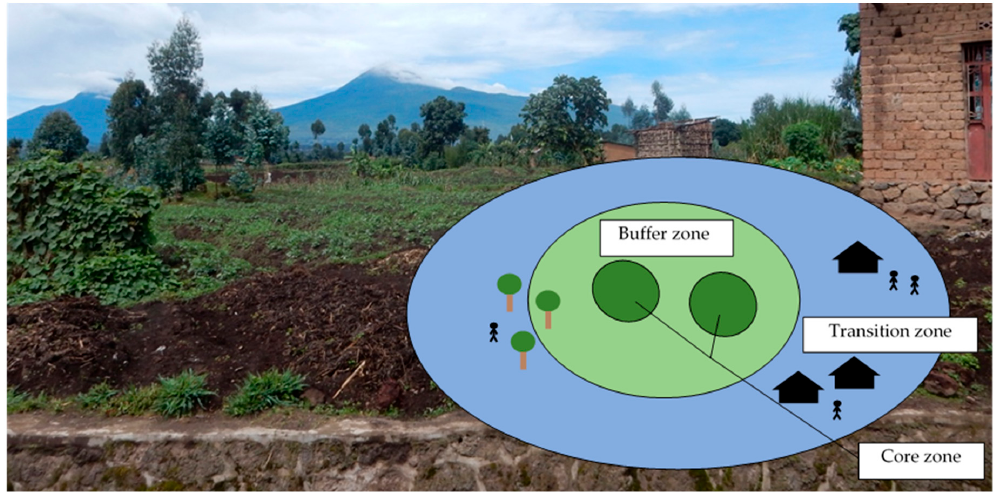
Figure 1. The zonation concept of the United Nations Educational Scientific and Cultural Organization (UNESCO) Biosphere Reserves; picture: Volcans Biosphere Reserve, Rwanda, with the volcanoes being the core zone; compiled by the authors.